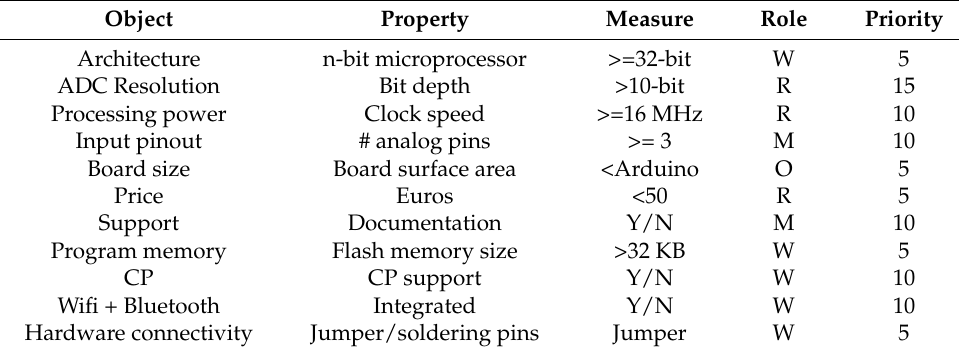
Table 2. Requirements for the microprocessor. A high score in the Priority column means greater importance for that criterion. CP = Circuit Python; ADC = Analog-to-digital converter; Roles: M = Mandatory, R = Restriction, W = Wish, O =